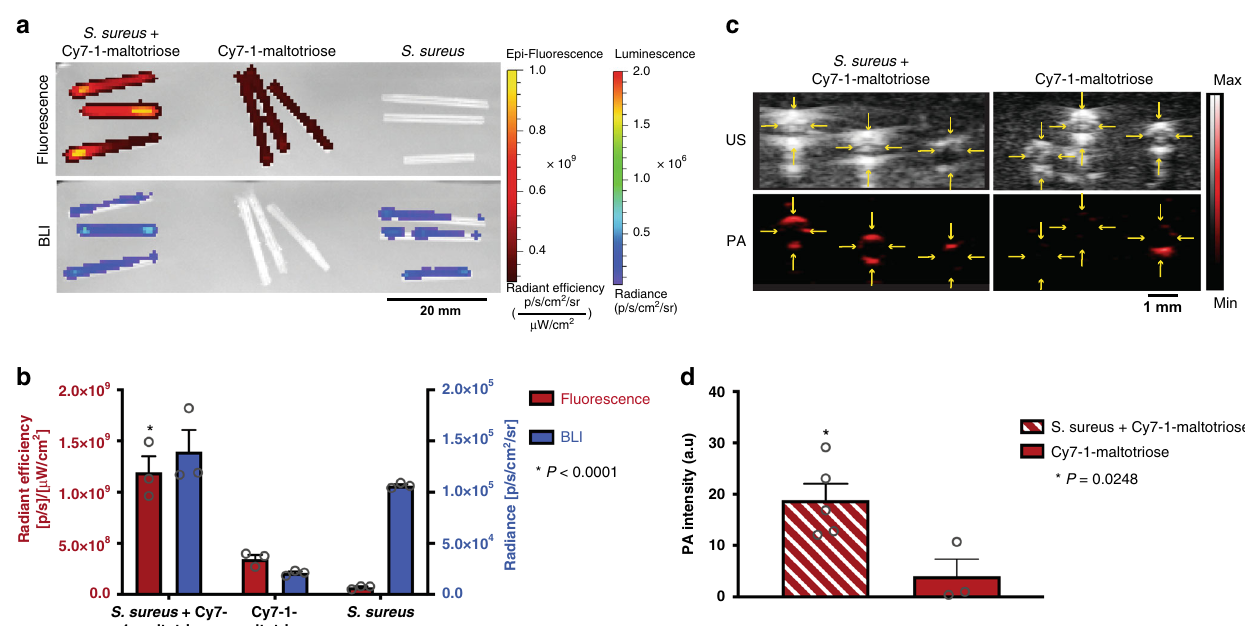
Fig. 5 In vitro evaluation of Cy7-1-maltotriose in a S. aureus -infected biomaterial model. a FLI and BLI images showcasing the presence and lack of S. aureus on catheters. High FLI and BLI signals were observed in catheters that were incubated with S. aureus followed by Cy7-1-maltotriose (left) compared to sterile catheters that were only incubated with Cy7-1-maltotriose (middle). Similarly, no FLI signal and only BLI signal was observed on catheters that were incubated with S. aureus only (right). b Total FLI and BLI signals in catheters infected with bioluminescent S. aureus and incubated with Cy7-1-maltotriose. Fluorescence quanti fi cation was plotted to the left y -axes (red) while BLI signal plotted to the right y -axes (blue) and showed signi fi cantly higher FLI signal in infected catheters compared to sterile catheters post incubation with a solution of Cy7-1-maltotriose ( P < 0.0001, n = 3). c Axial US and PA imaging showcasing the presence and lack of S. aureus on catheters upon incubation with Cy7-1-maltotriose. An evident PA signal was observed in axial images of catheters incubated with S. aureus followed by Cy7-1-maltotriose (bottom left), compared to sterile catheters that were only incubated with Cy7-1-maltotriose (bottom right). Yellow arrows mark the catheter ’ s outline. d Bar plot representation of the quanti fi ed photoacoustic signal intensity in the axial photoacoustic images of infected and sterile catheters post incubation with Cy7-1-maltotriose. The infected catheters ( n = 5) had signi fi cantly higher PA signal compared to sterile catheters ( n = 3) post incubation with Cy7-1-maltotriose ( P = 0.0248). Bar graphs show mean and S.E.M. Statistical analysis was performed using two-way ANOVA. The source data underlying Fig. 5b and d are provided in a Source Data fi